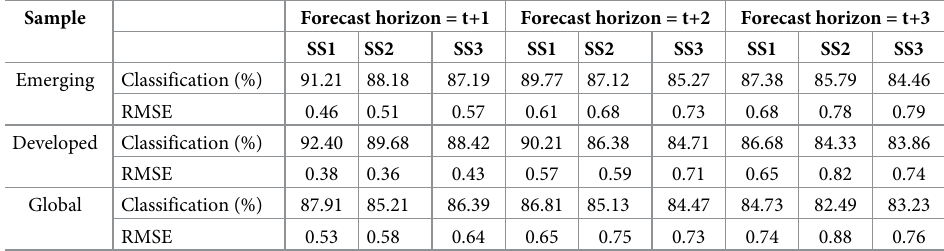
Table 11. Multiple-step ahead forecasts and RMSE score.